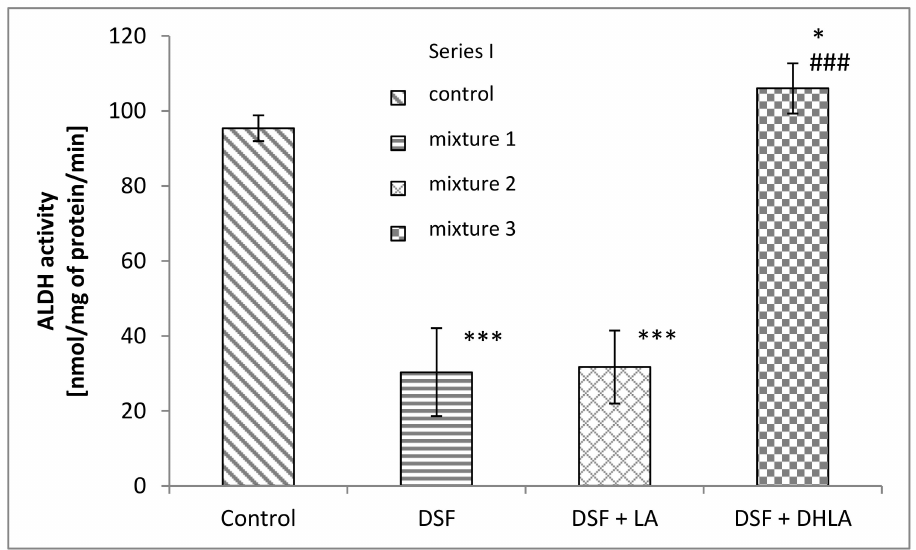
Figure 4. The e ff ect of 1 mM LA and DHLA on DSF-inhibited ALDH in the rat liver homogenate. Only DHLA was able to restore ALDH activity blocked by DSF. The experiment was performed in triplicate. Data are shown as the mean ± SD. Significant vs. control sample: * p < 0.05; *** p < 0.001. Significant vs. DSF sample: ### p <